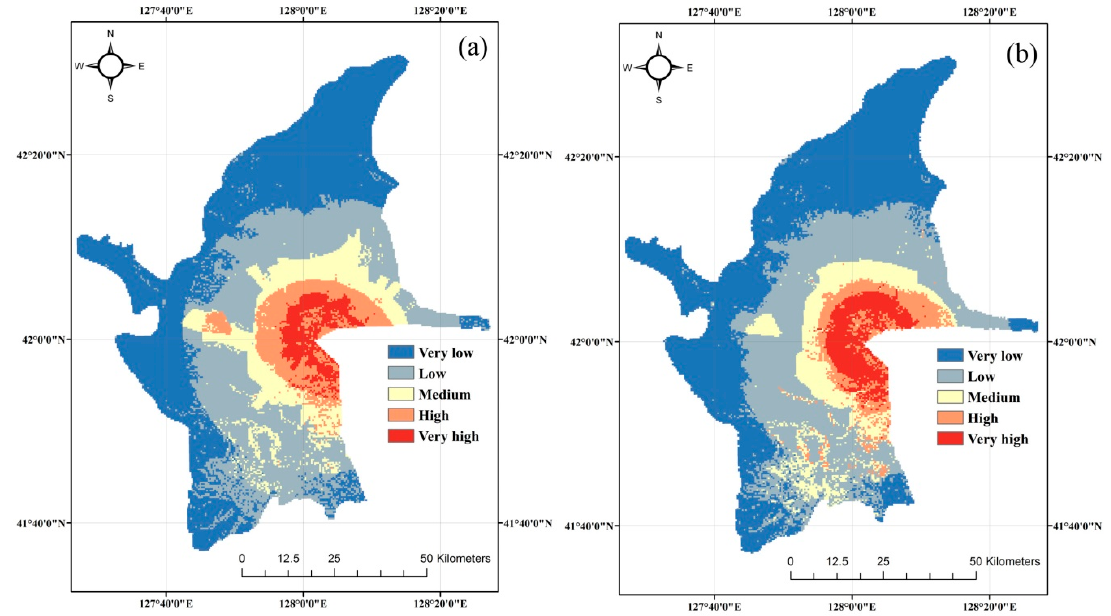
Figure 8. BN model disaster chain susceptibility maps for the chains: ( a ) Earthquake-landslide and ( b ) Earthquake-landslide-debris flow.